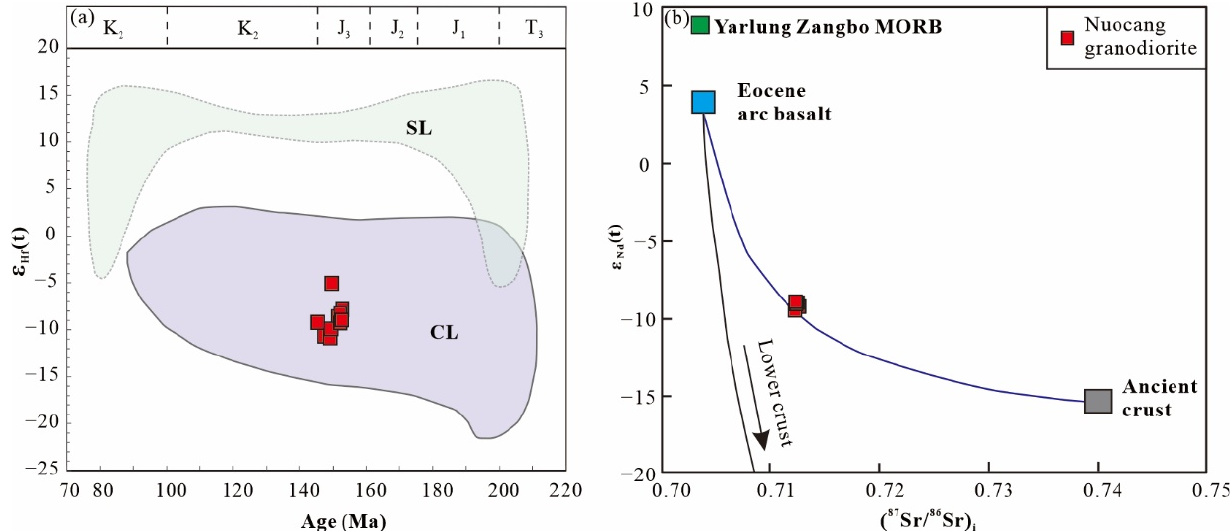
Figure 9. ( a ) ε Hf(t) vs. U-Pb age diagram of zircons from the Nuocang granodiorites; ( b ) 87 Sr/ 86 Sr(i) vs. ε Nd(t) for the Nuocang granodiorites. CL- the Hf values of granitoids in the central Lhasa terrane; SL- the Hf values of granitoids in the southern Lhasa terrane; The Yarlung Zangbo Mid-ocean ridge basalts (MORB) is from [4]: ε Nd(t) = +7.0, Nd = 1.2 ppm; The mantle-derived basaltic magmas (represented by the Dazi basalt; [59]): ( 87 Sr/ 86 Sr)i = 0.7043, ε Nd(t) = +5.2, Sr = 291 ppm, Nd = 9.6 ppm; Ancient crustal (represented by a strongly peraluminous granites from the central Lhasa terrane; [4]): (87Sr/86Sr)i = 0.7402, ε Nd(t) = − 15.4, Sr = 131 ppm, Nd = 43.40 ppm. The central Lhasa terrane is from [4] and [20].